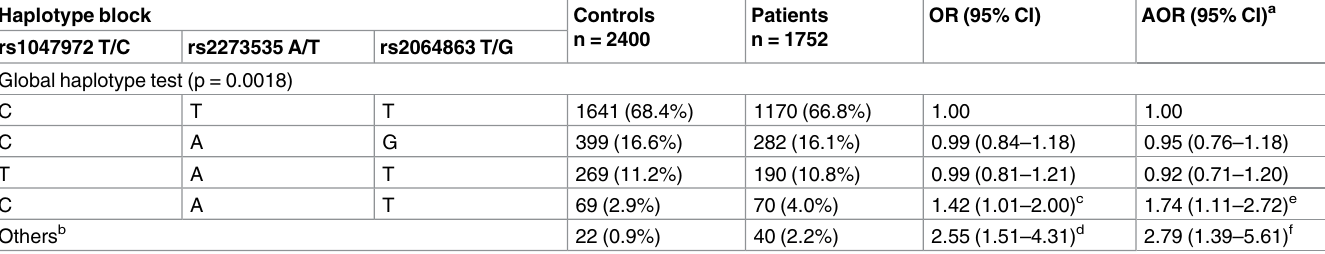
a Adjusting for the effects of age, betel quid chewing, cigarette smoking and alcohol drinking b Others: TAG (41), TTT (15), and CTG (6) c